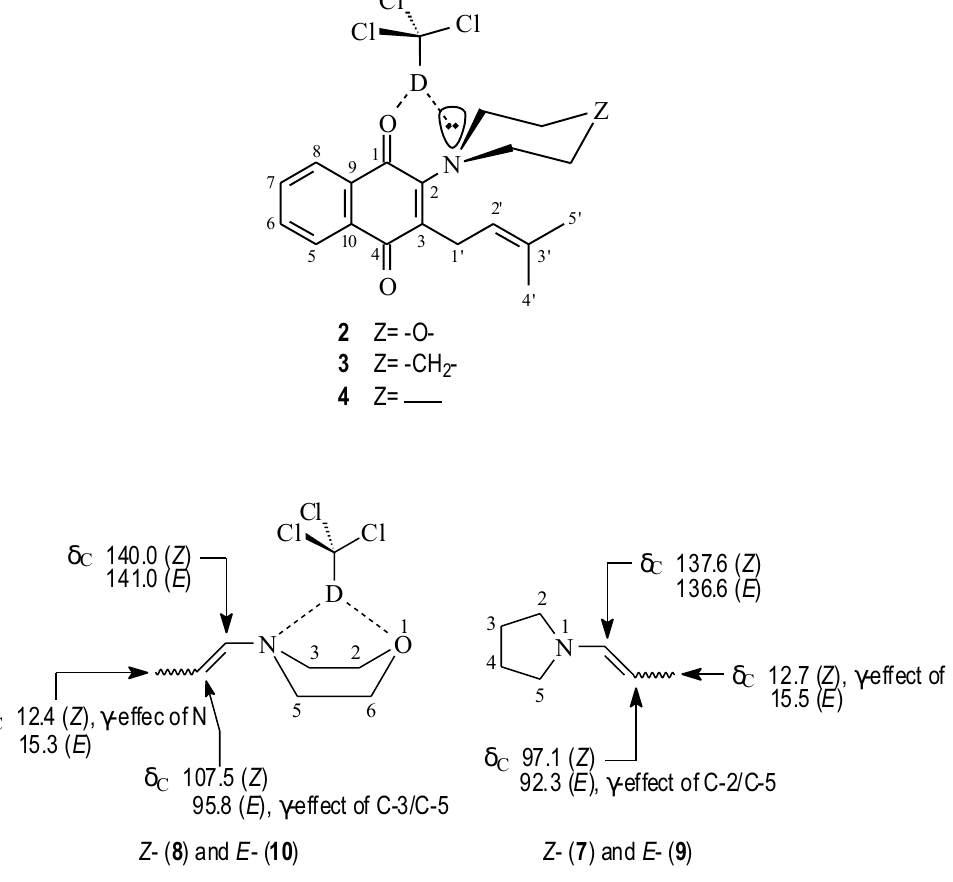
Fig. 5 – Intermolecular deuterium bonding of solvent CDCl 3 with derivatives 2-4 and model compounds 7-10 described in the literature (Giasuddin et al. 1978, Breitmaier and Voelter